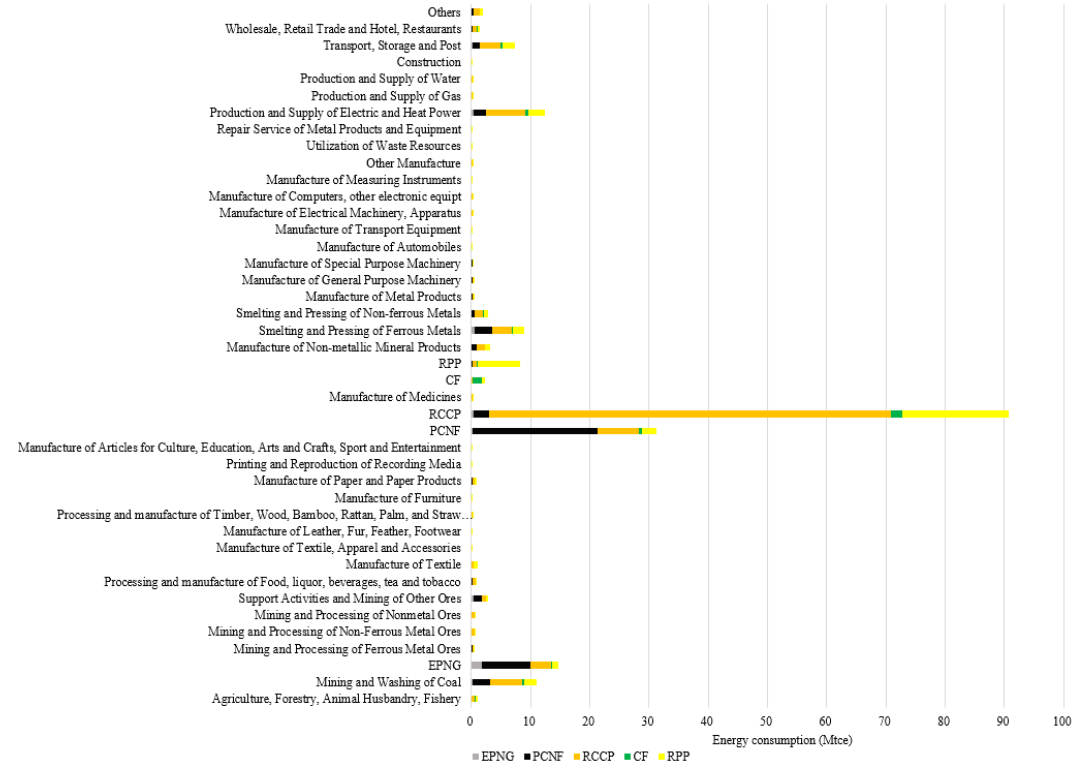
Figure 4. Contribution of sectors to indirect energy consumption of the petrochemical industry (2012).